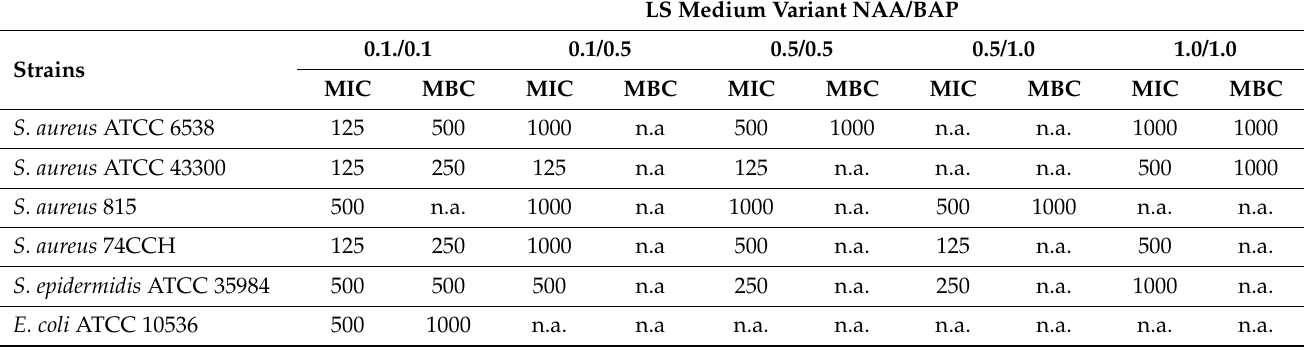
Table 4. MIC and MBC values ( µ g/mL) of methanol extracts obtained from biomass of R. montana bioreactor cultures grown on LS medium variant supplemented with different concentrations of NAA/BAP, 5-week growth